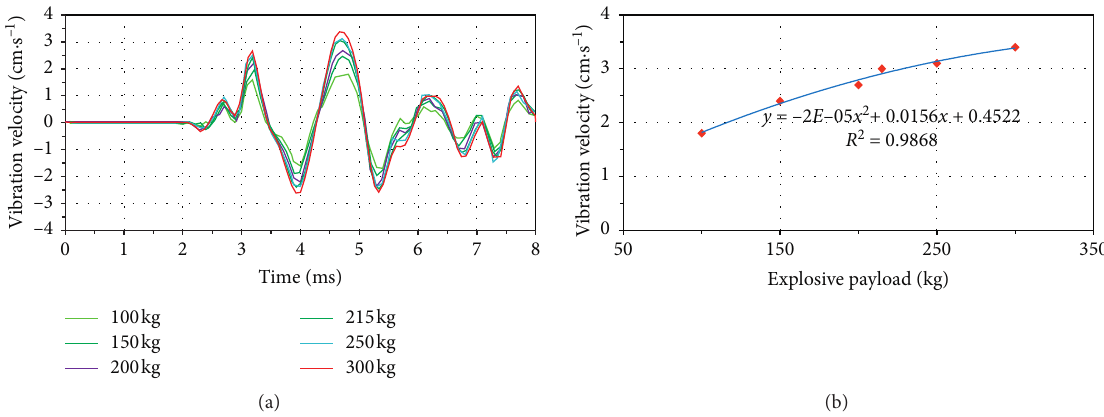
Figure 7: Vibration velocity of steel central position with different explosive payloads. (a) Velocity history curves of particle under different explosive payloads. (b) Positive velocity fitting curve under different explosive